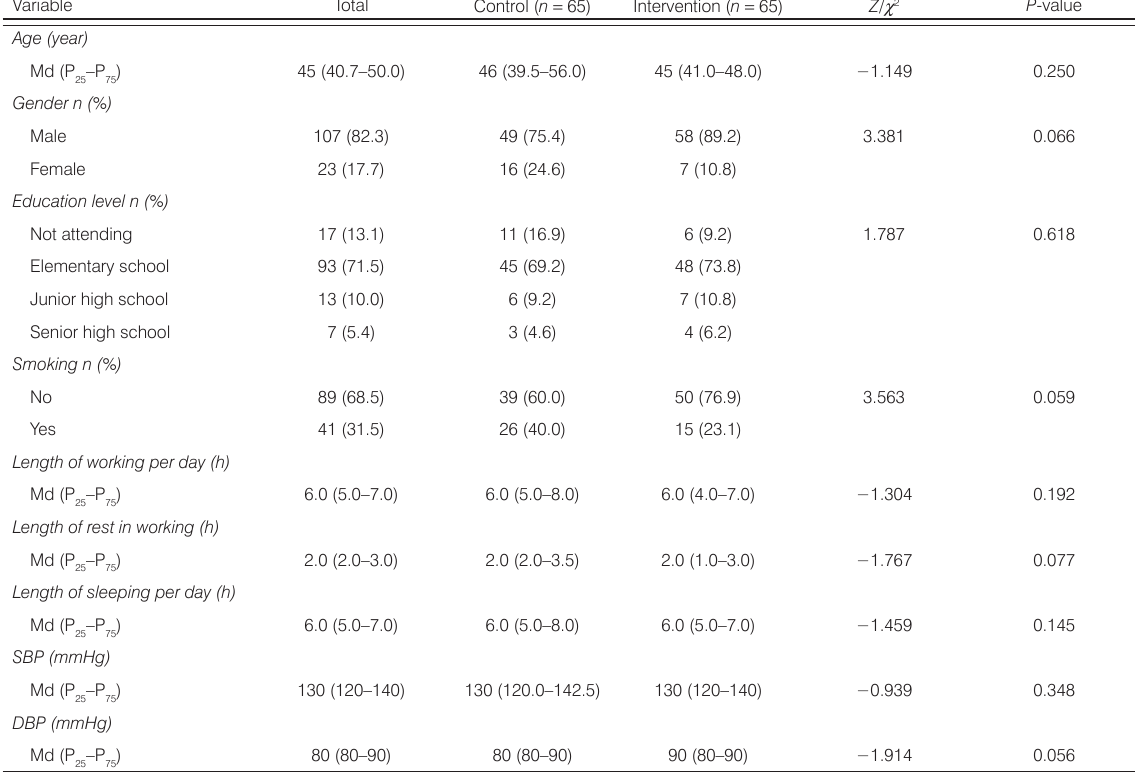
Table 1. Baseline characteristics of participant and BP ( n =